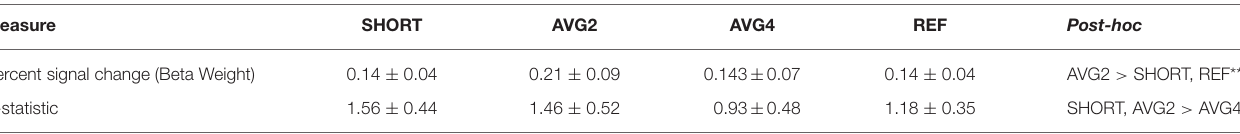
TABLE 2 | Post-hoc results for repeated measures ANOVAs for BOLD signal change and GLM-calculated T -statistics for the full Harvard-Oxford brain atlas.